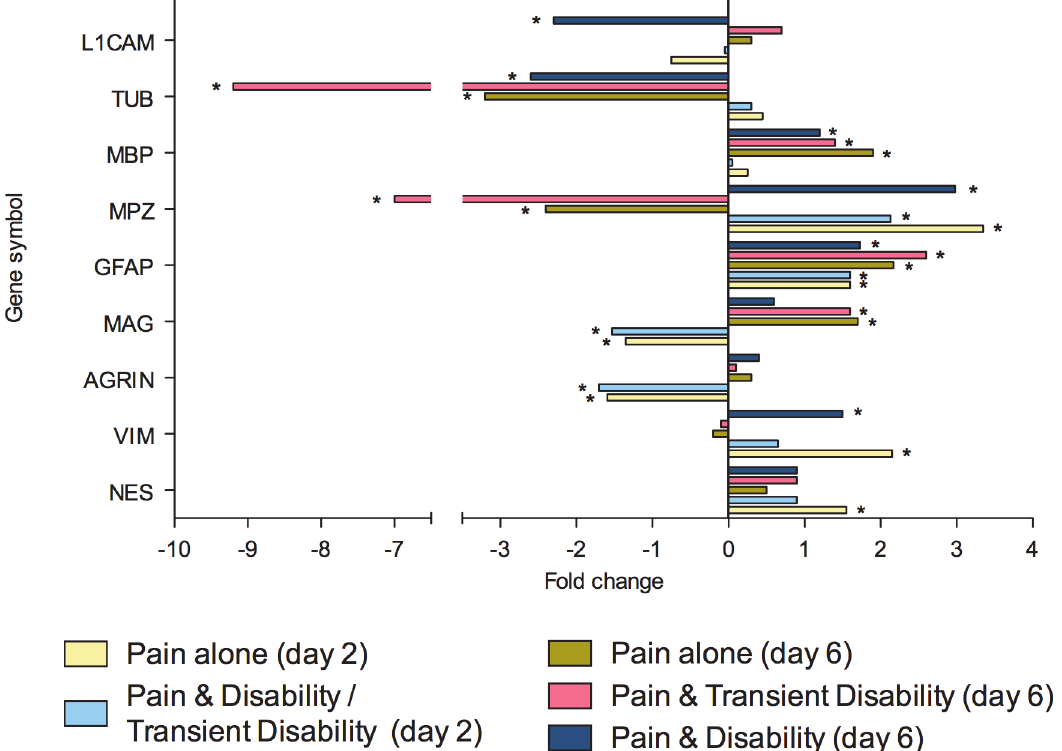
Fig 5. Gene transcripts, which encode for proteins involved in cellular structure, that are specifically regulated in the lumbar spinal cord after CCI, as determined by microarray analysis. Changes in gene expression have been tested at both 2 and 6 days after CCI on pooled mRNA samples from each disability group, compared to uninjured controls. * Indicates up- or down-regulation determined by MAS v5.0.